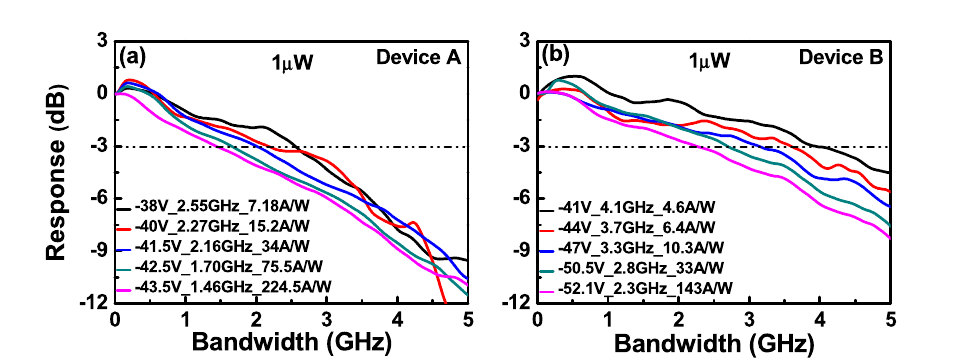
Figure 5. Measured bias dependent O-E frequency responses under 1 µW optical pumping power of: ( a ) Device A. ( b ) Device